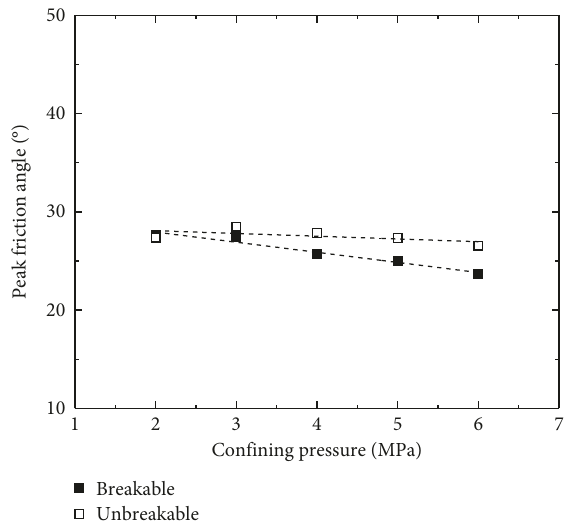
Figure 8: Peak friction angle for all samples with breakable and unbreakable